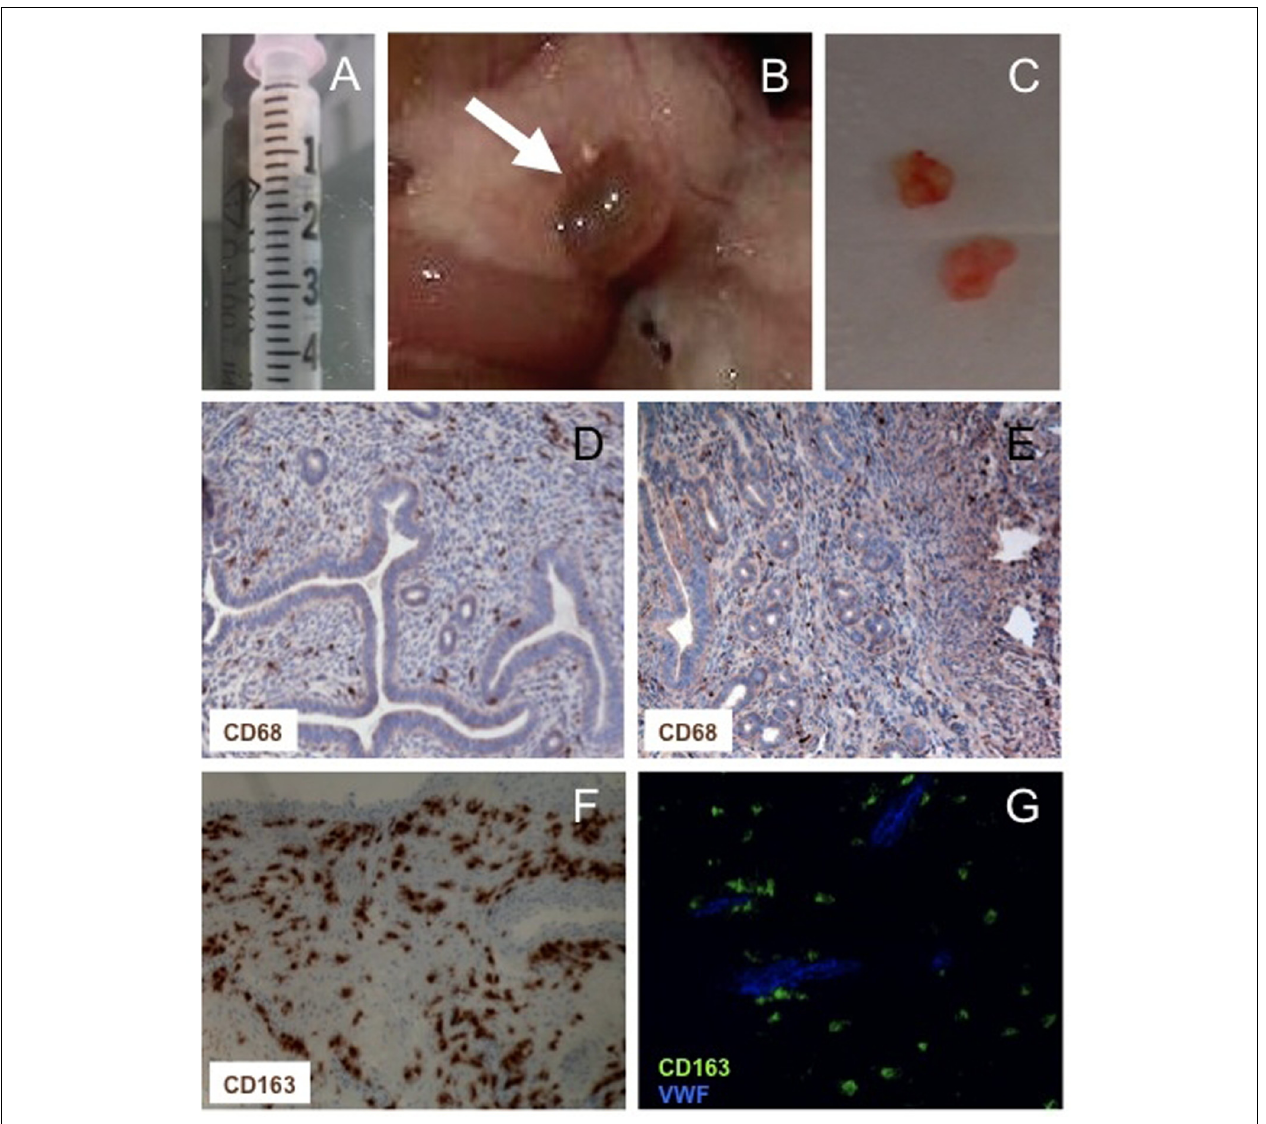
in human and experimental lesions (D,E) . Most macrophages within human lesions express markers of alternative activation, such as the hemoglobin/haptoglobin CD163 scavenger receptor (F) . CD163 + (green) vWF- (blue) pro-angiogenicTie2-expressing macrophages surround the neoformed vessels (G)